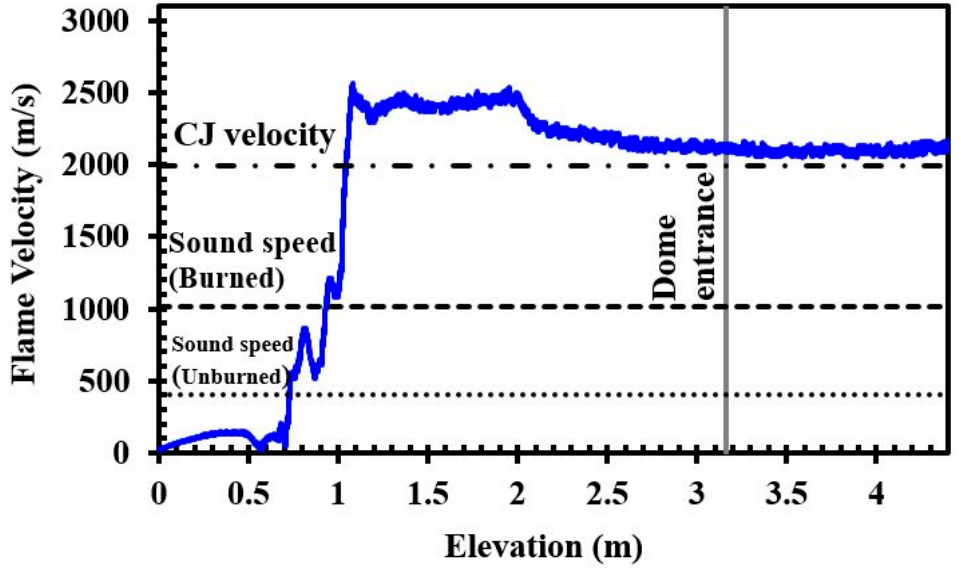
Figure 10. Flame-tip velocity in H 2 –air mixture with 30% hydrogen concentration .